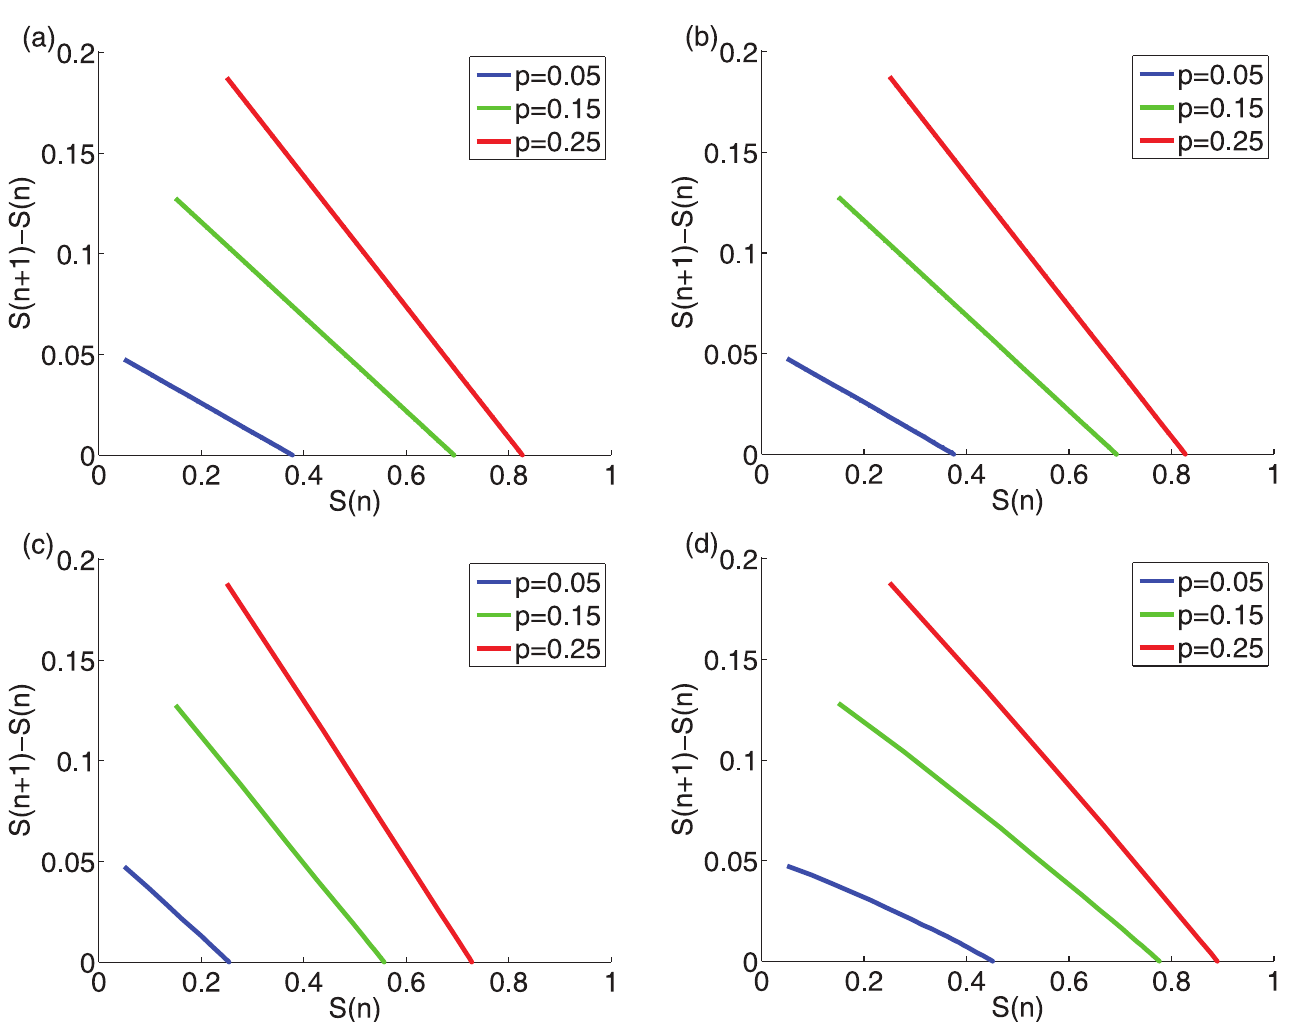
Fig 8. Phase-space diagrams for the uniform random threshold distribution ( σ = 0.288). for various initiator fractions p = 0.05 (blue), p = 0.15 (red) and p = 0.25 (green) for (a) ER graphs, (b) SF networks, (c) high-school network, and (d) facebook network as in Fig 1. The solid lines and dotted lines (complete overlap) correspond to the simulations and to the closed-form analytic estimates [Eq (2)],